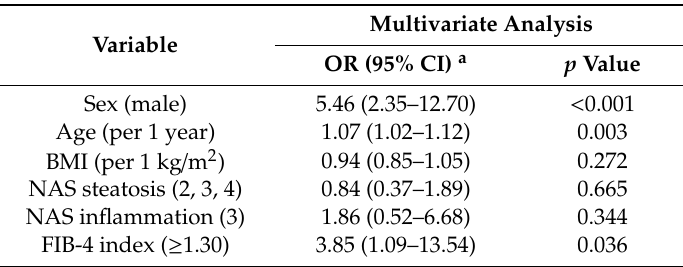
Table 2. Factors associated with chronic kidney disease in patients with non-alcoholic fatty liver disease in the total study cohort identified by multivariate